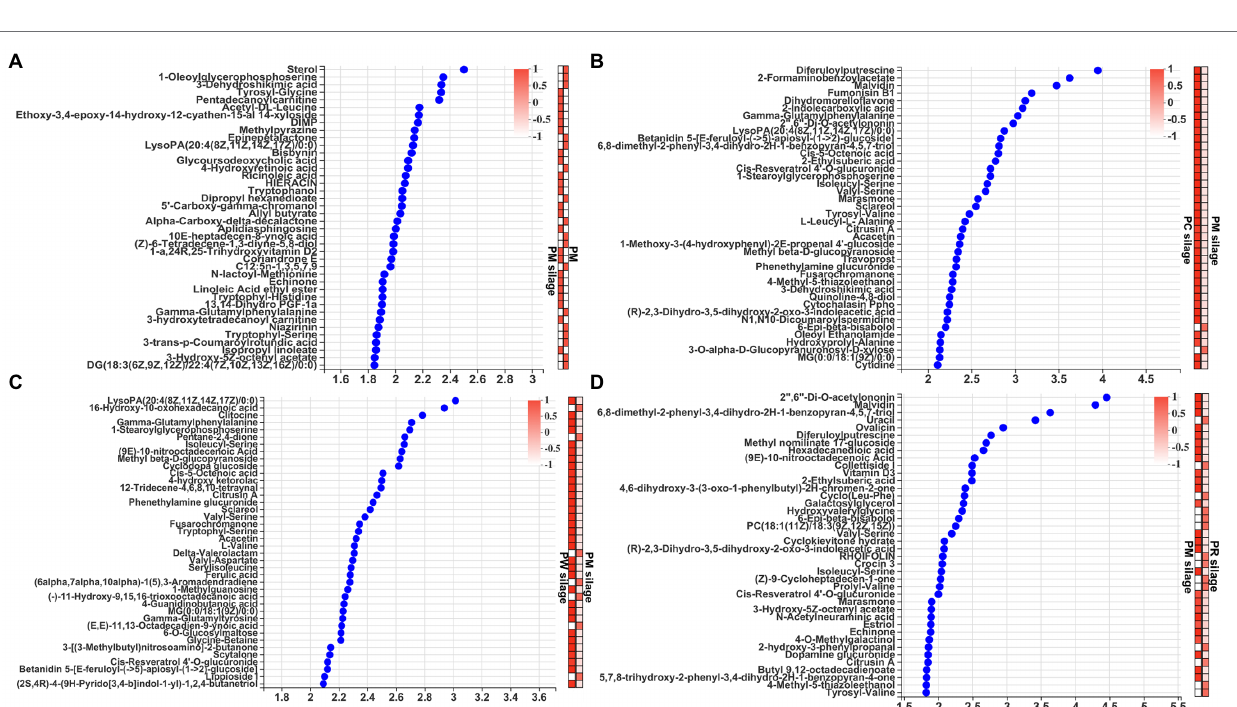
Lipids and lipid-like molecules